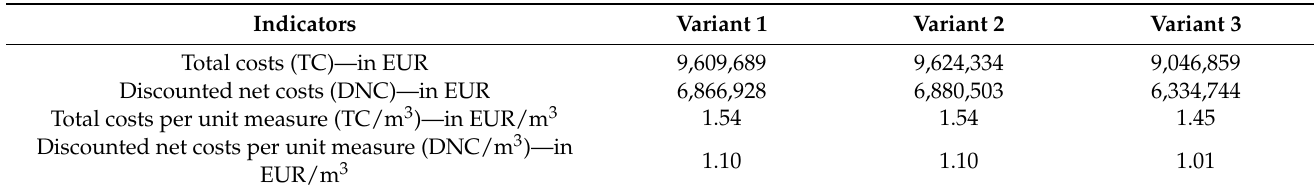
Table 4. Recapitulation of comparative financial analysis for offered technical variants of WWTP.